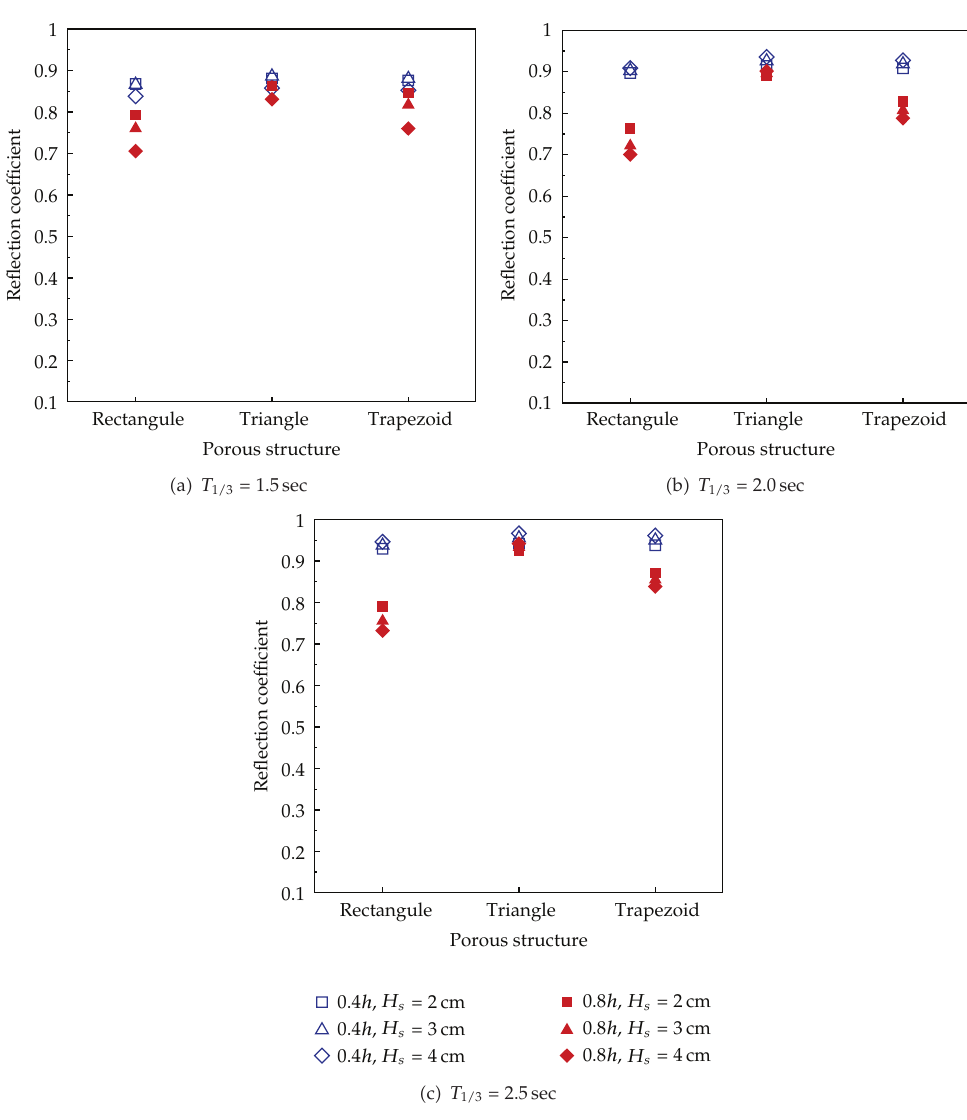
Figure 7: Reflection coe ffi cient for vertical caisson with di ff erent shapes of porous